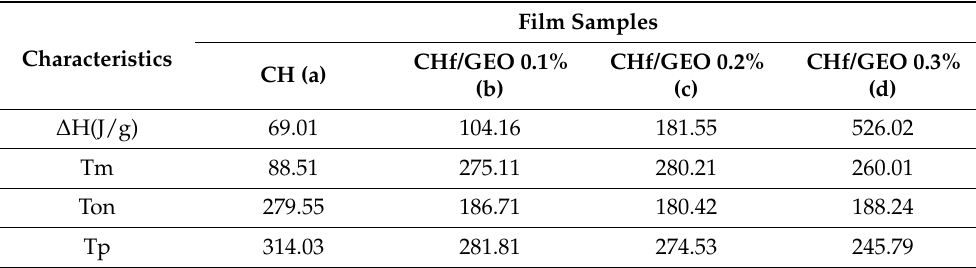
Table 3. DSCcharacteristicsofexaminedsamplesbasedonCHf/GEO.( a )Chitosan; ( b ) Chitosan + 0.1% GEO;